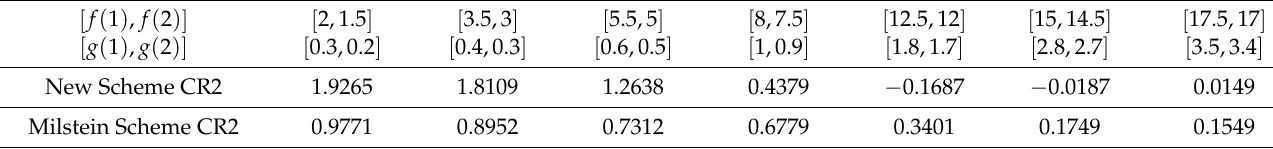
Table 5. Multiple groups of state values and convergence rates of three schemes with X 0 = 0.25.